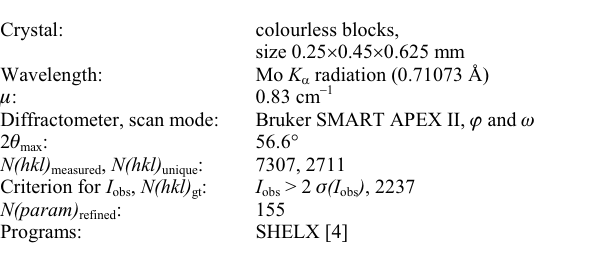
Table 1. Data collection and handling.